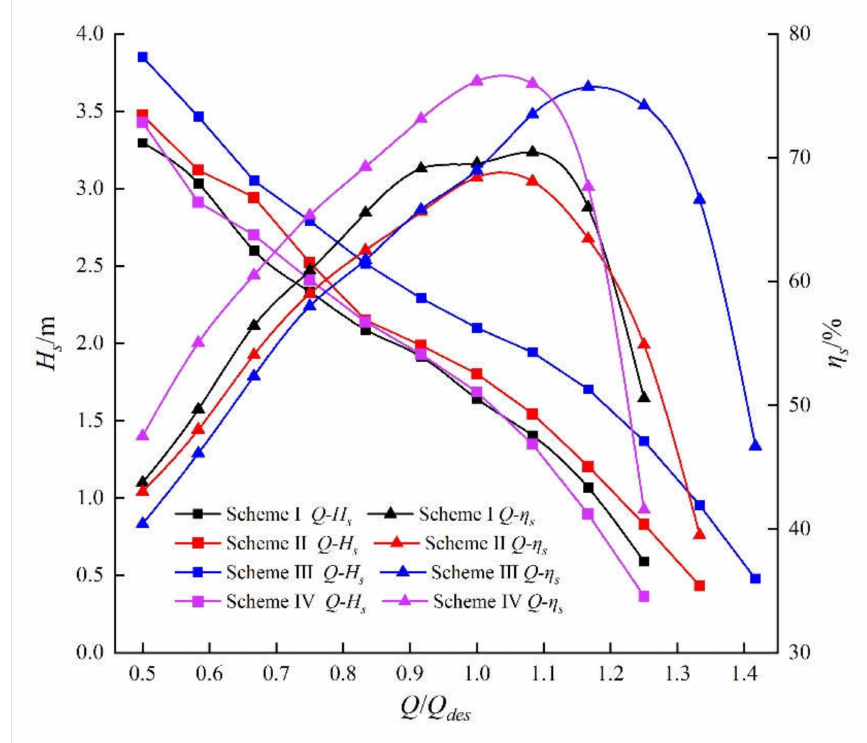
Figure 11. Performance curve of pump device in different schemes.